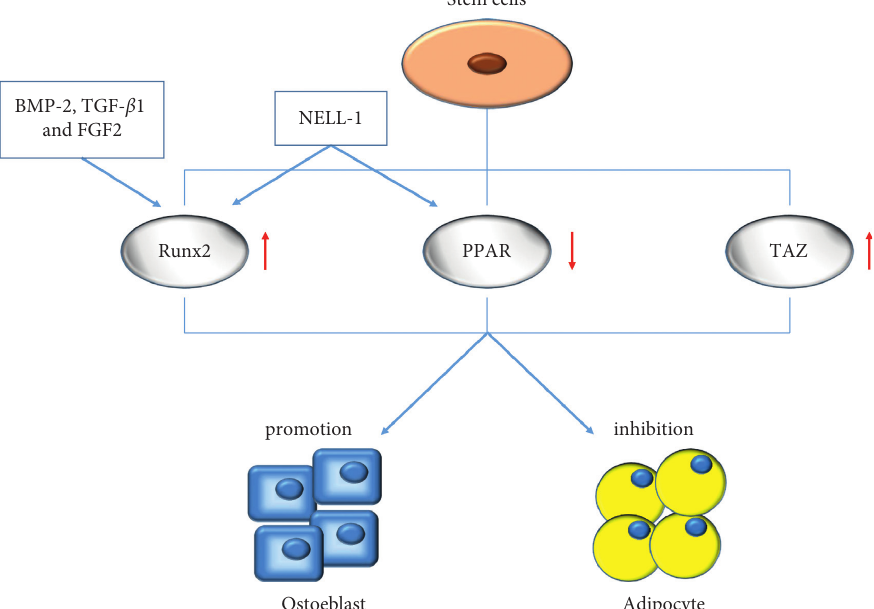
Figure 1: Schematic representation of signaling pathways which induce the switch between osteogenesis and adipogenesis in